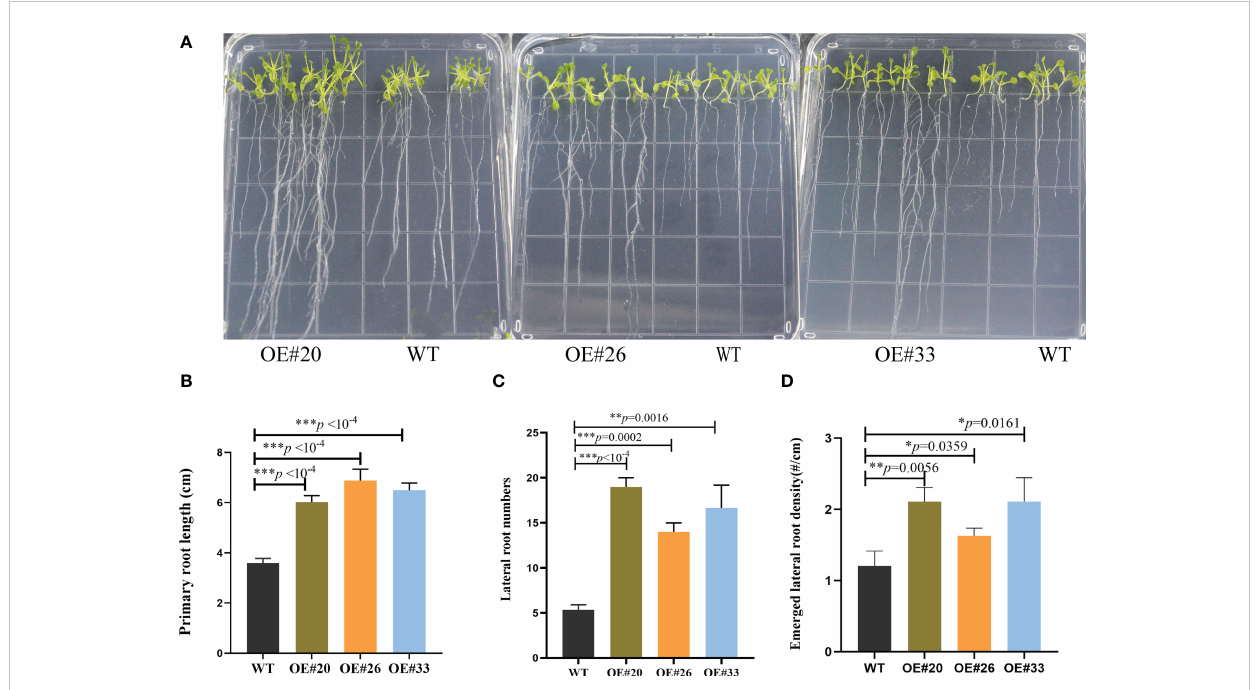
FIGURE 4 MirMAN regulation of root development on transgenic Arabidopsis plants. (A) The phenotypic root observation of wild type (WT) and MirMAN-OE lines. (B) Length of the primary root. (C) Number of lateral roots. (D) Density of lateral root primordia. The seedlings were cultured for 12 days. Data are means ± SD (n = 10). *p< 0.05, **p< 0.01, ***p < 0.001, independent-samples t